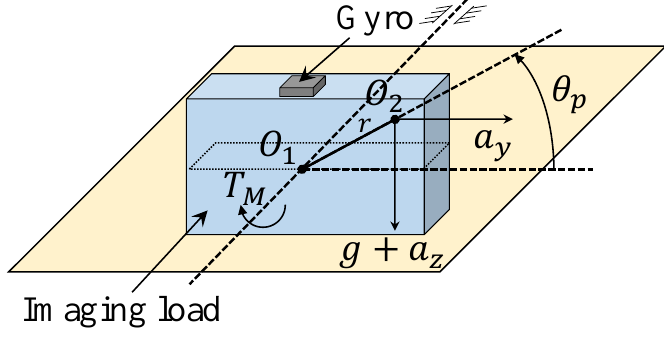
Figure 3. Schematic diagram of mass